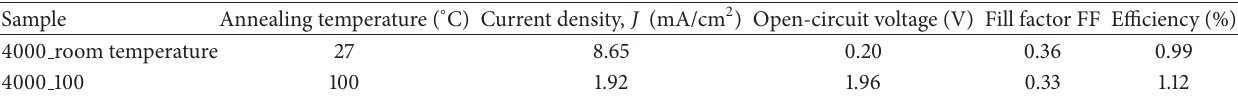
Table 3: Efficiency of CuInSe :ZnS solar cell at produced room temperature and annealing temperature of 100 ∘ C. 2 Sample